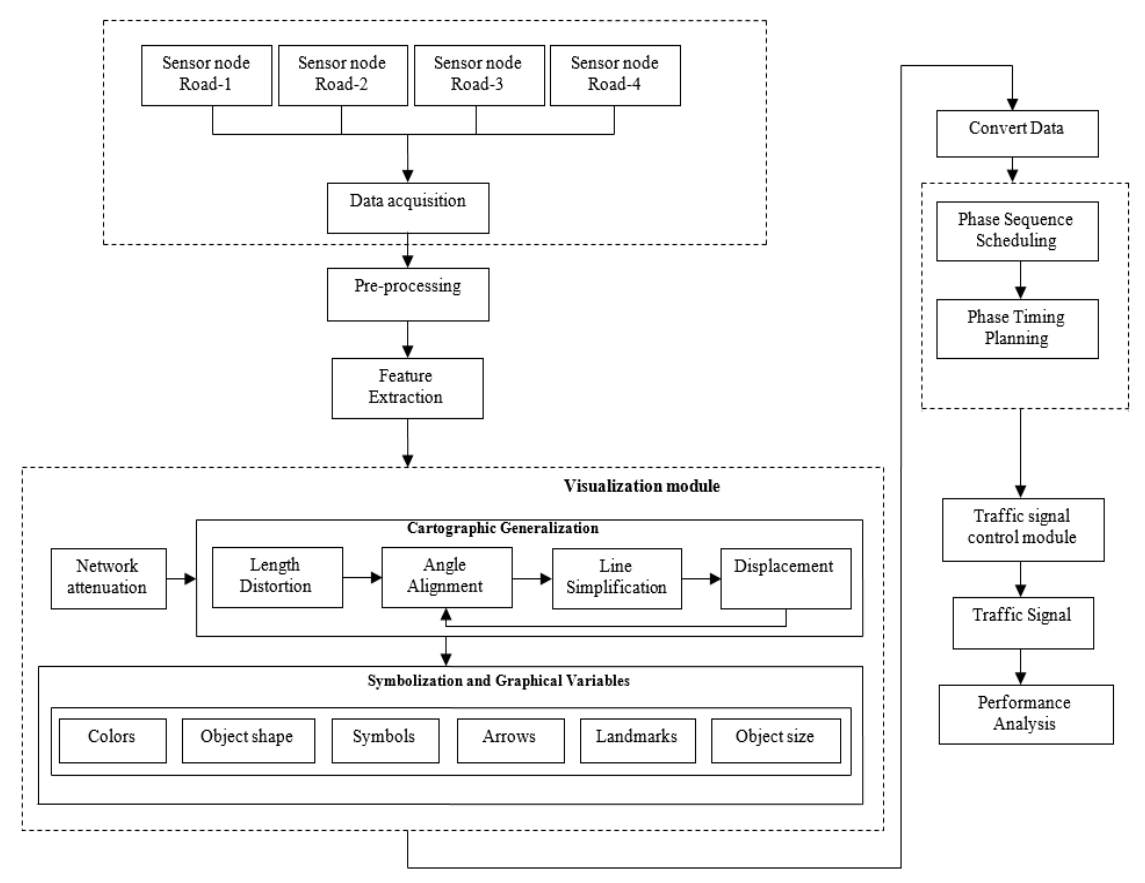
Figure 1. The schematic representation of the proposed method.